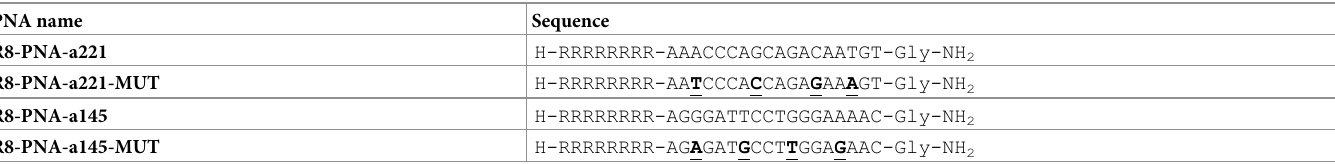
Table 1. Sequences of PNAs. Mutated bases are